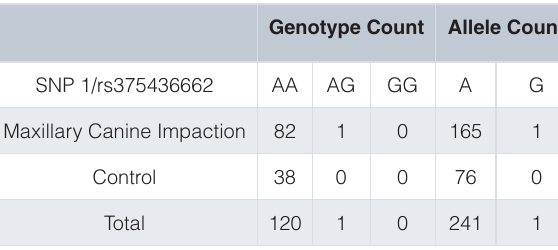
Table 4. Genotype analysis of SNP 1 in case and control samples.